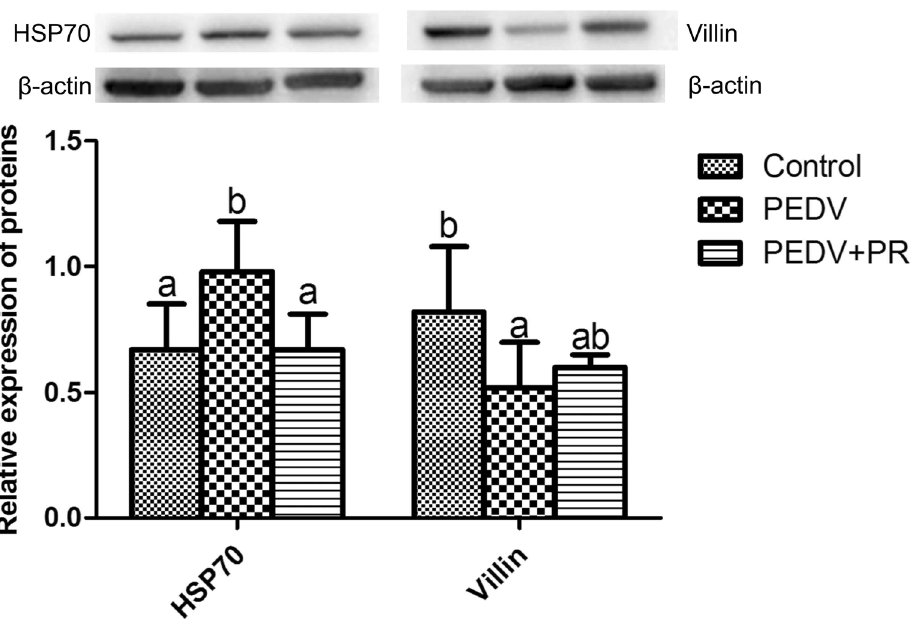
Figure 5. Effects of puerarin (PR) administration on relative expression of HSP70 and Villin in ileum tissue of piglets after PEDV infection. Values are mean and SD, n = 8. a, b, c , Values within a column not sharing a common superscript letter indicate significant difference at P <